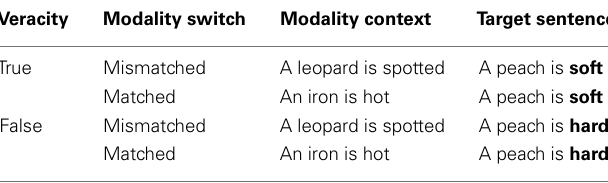
Table 1 | Example tactile materials from Hald et al. (2011).